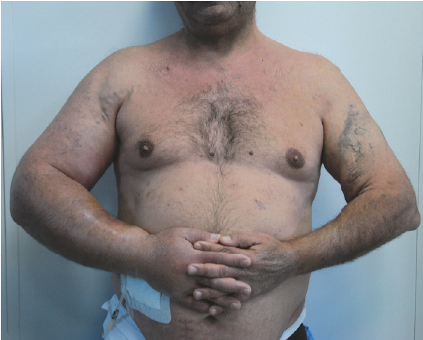
Figure 3: Excessive edema of the right upper arm. Inserted peritoneal dialysis